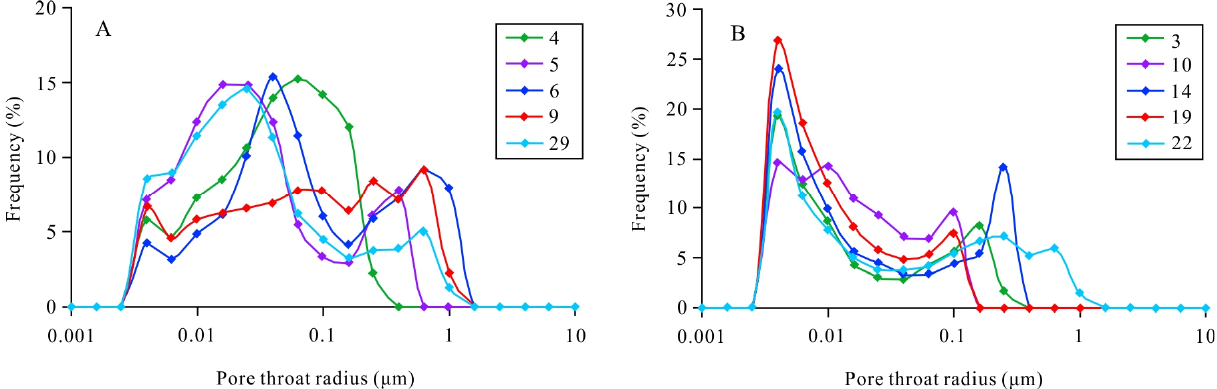
Figure 7. ( A ) Pore throat radius of samples with pore-lining chlorite. ( B ) Pore throat radius of samples without pore-lining chlorite.